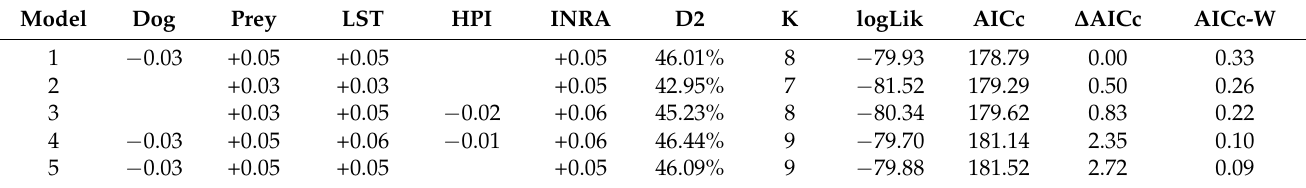
Table 8. Exploratory analysis of potential explanatory variables for observed variability in the RAI of South American grey fox ( Lycalopex griseus ). Only the best five models, as ranked by AICc values, are shown. Positive/negative signs indicate variables and effects considered by each model. Codes are the same as in Table